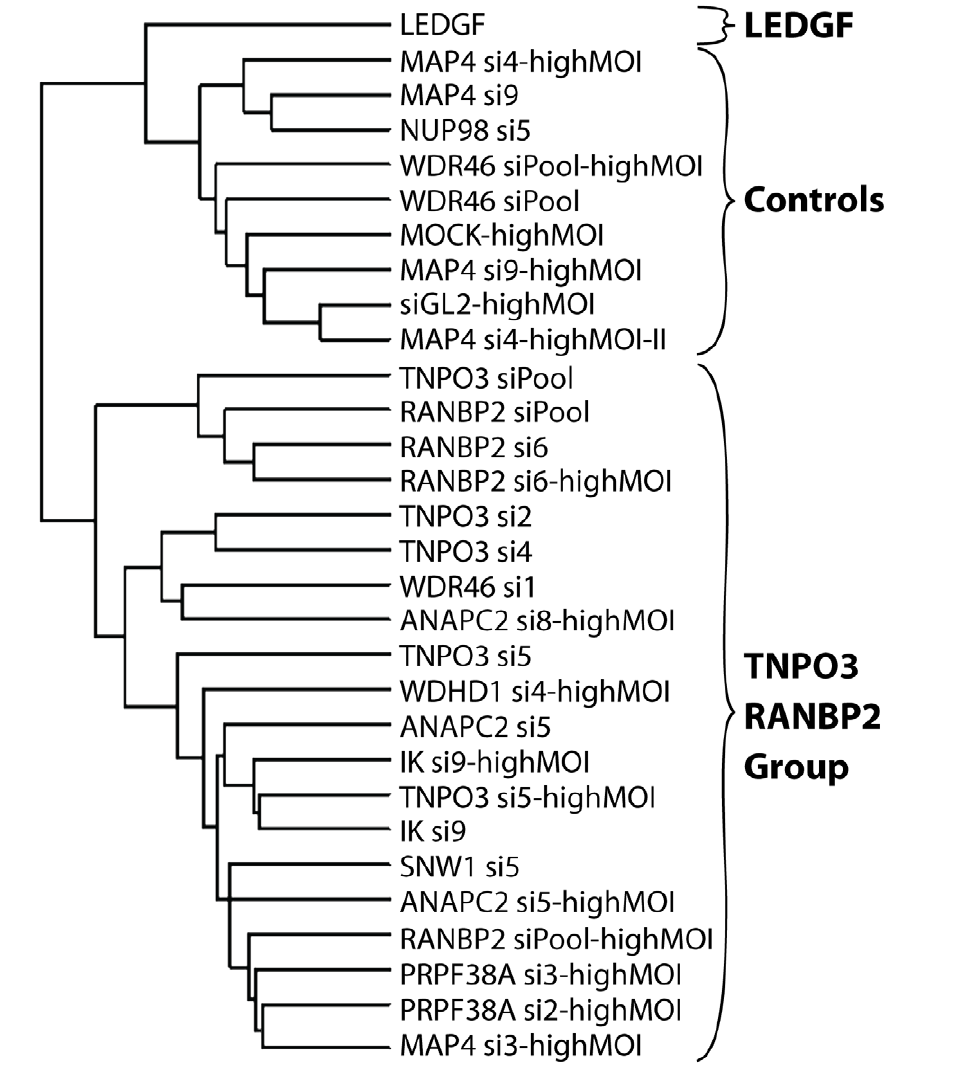
Figure 6. Dendrogram showing clustering of integration site data sets from knockdowns of Transportin-3, RanBP2, and several additional factors. Only sets containing at least 200 integration sites were used for the analysis. A conditional logit model was used to cluster integration sites data sets based on annotation of in or out of annotated transcription units, gene density, expression density, CpG islands, G/C content, nearby oncogenes, and local sequence features (Text S3). Sets were clustered based on their overall similarity in a pairwise analysis. The "Control" cluster is so named because it contains the Mock and siGL2 control data sets. Branch labels indicate the siRNA used for the analysis, and indicates the name of the targeted gene (e.g. TNPO3 si4). Infections were performed using enough HIV vector stock to infect 30–60% of untreated cells except where marked as ‘‘highMOI’’ where 90–100% of untreated cells were infected.